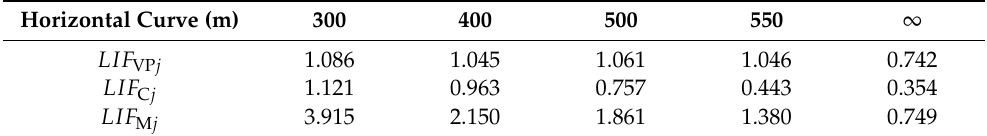
Table 5. Linear influence factor over different